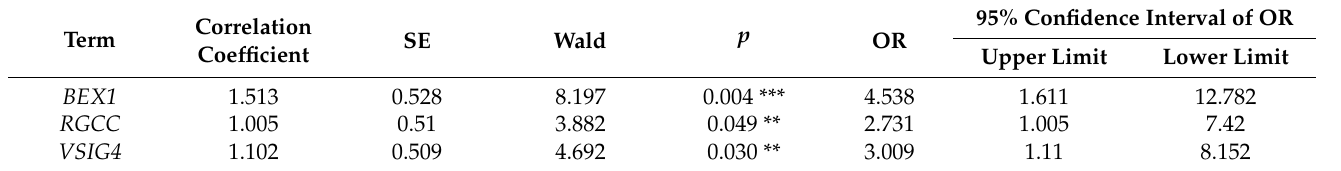
Table 2. Binary logic regression